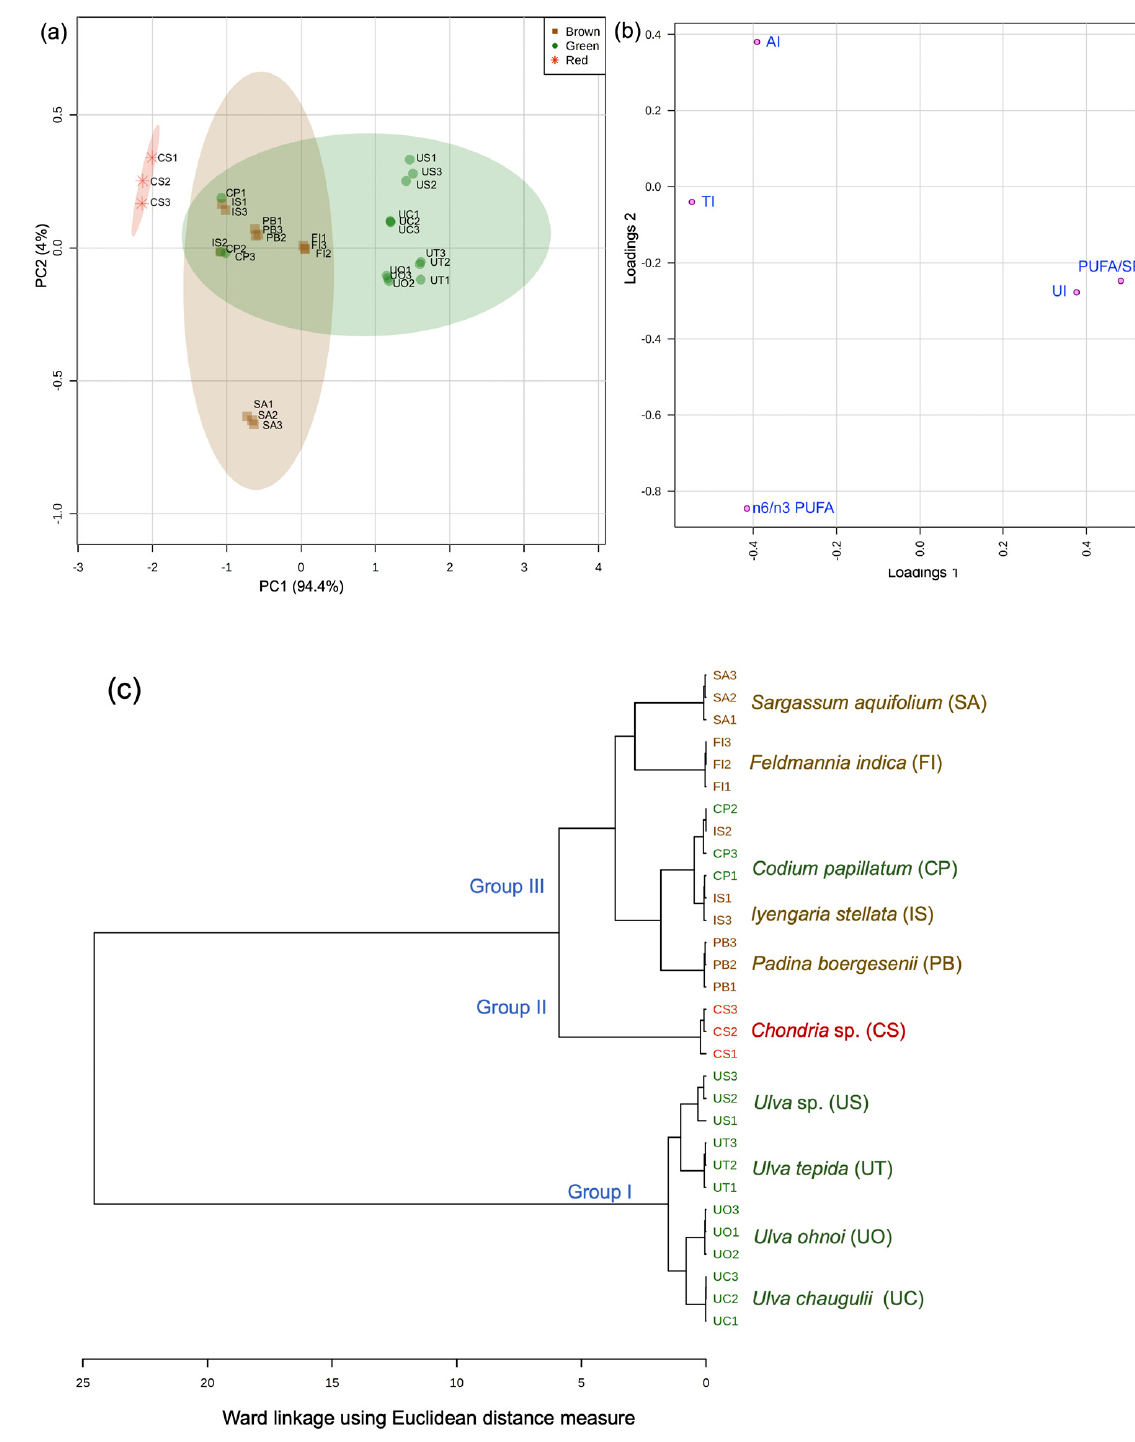
Figure 2. Principal component analysis (PCA) and hierarchical clustering of seaweeds based on nutritional indices. ( a ) PCA scores plot and ( b ) PCA loadings plot and ( c ) dendrogram obtained from hierarchical clustering using Ward linkage and Euclidean distance measures. Seaweed species are labeled as mentioned in Table 1. Abbreviations: AIatherogenic index, PUFApolyunsaturated fatty acids, SFAsaturated fatty acid, STAstearidonic acid, TIThrombogenic index, UIunsaturation index. The dendrogram obtained from hierarchical clustering of nutritional indices data revealed three demarcated clusters (Figure 2c). All of Ulva spp. (containing high UI and PUFA/SFA) were clustered together in Group I, like the Ulvales clade deduced from the